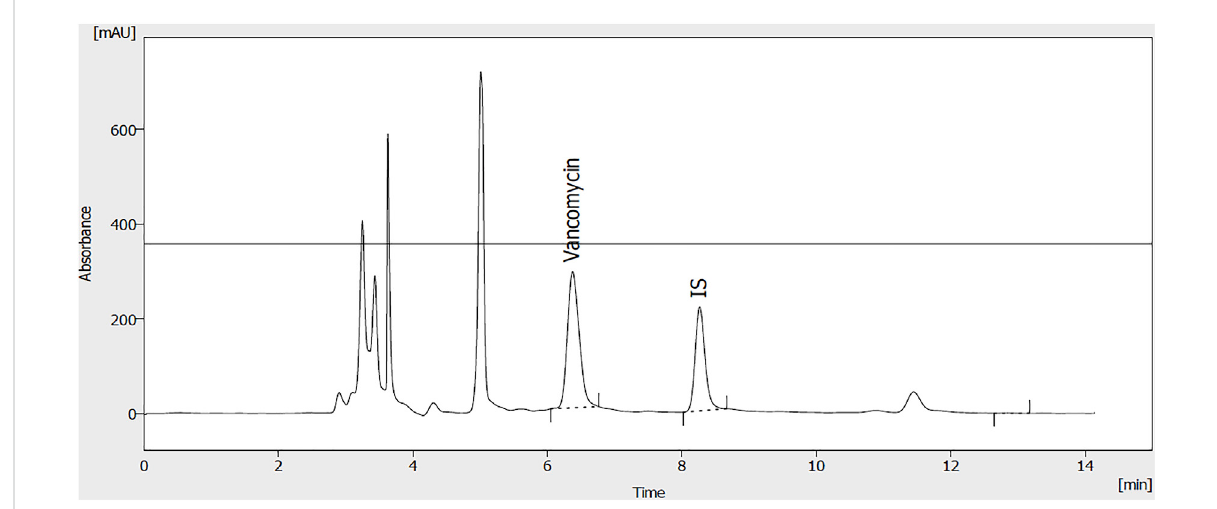
FIGURE 2 A representative chromatogram of vancomycin (50 μ g/ml) and internal standard (theophylline; 20 μ g/ml) extracted from plasma